Question: Which kind of chart has been used to present this data?
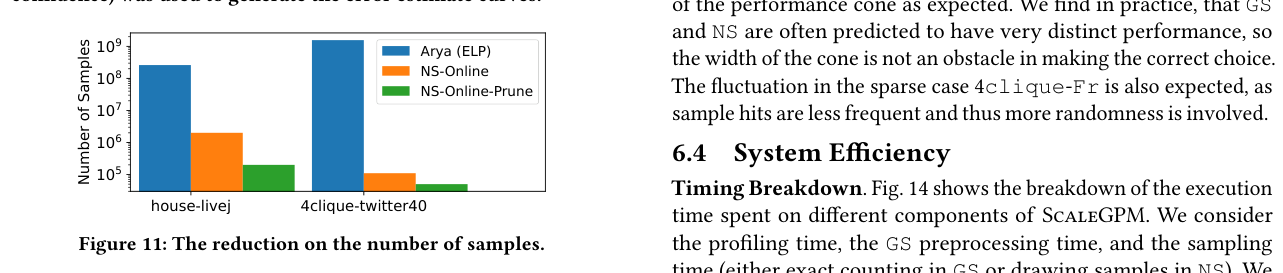
Answer: line